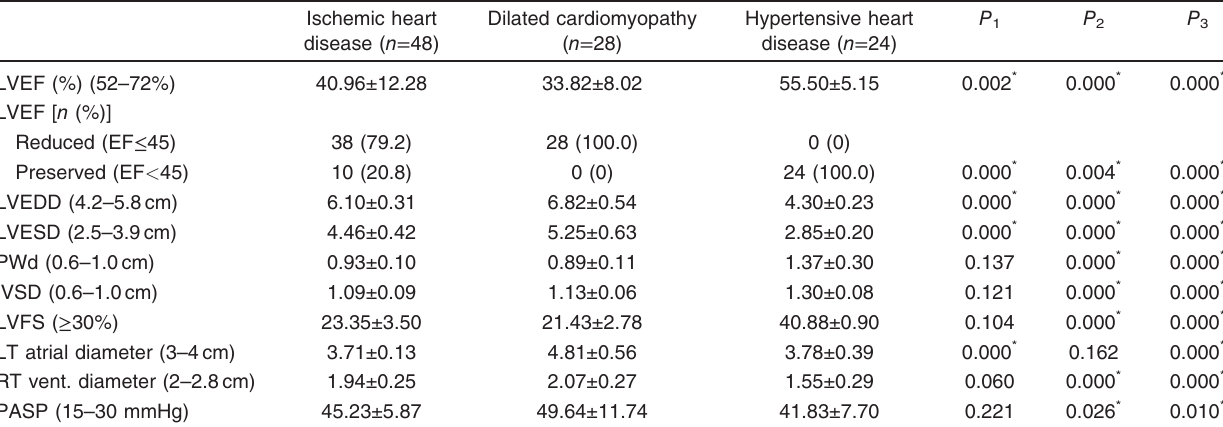
P 1 P 2 P 3 Ischemic heart Dilated cardiomyopathy Hypertensive heart disease ( n = 48) ( n = 28) disease ( n = 24)